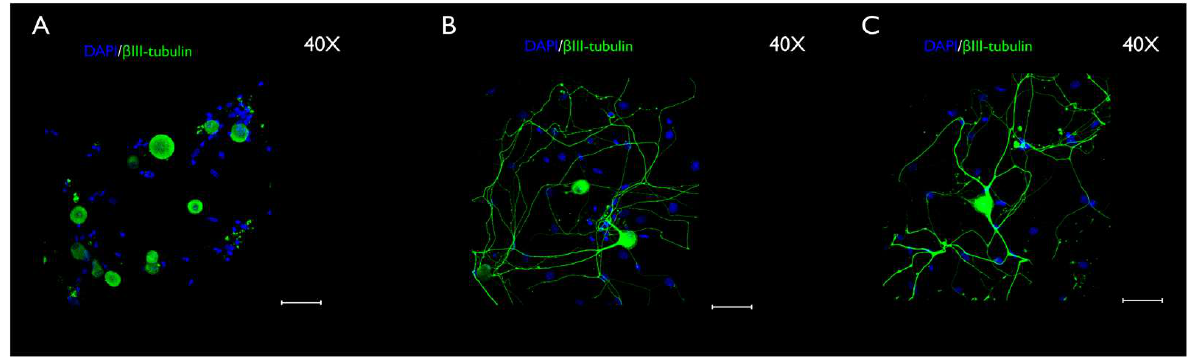
Figure 10. SK3 fluorescence quantification at each time point (4 h, 24 h, and 48 h). * p < 0.05) **** p < 0.0001.